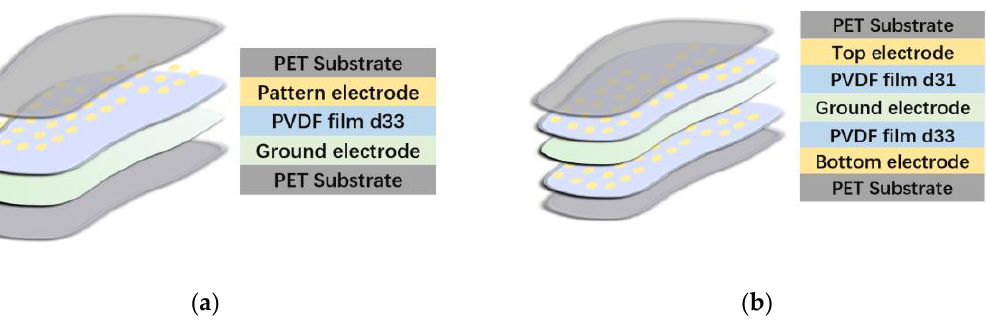
Figure 6. ( a ) Insole system [22], where one layer of PVDF was used; ( b ) insole system [12], where two different PVDF layers were used to detect shear and normal force.